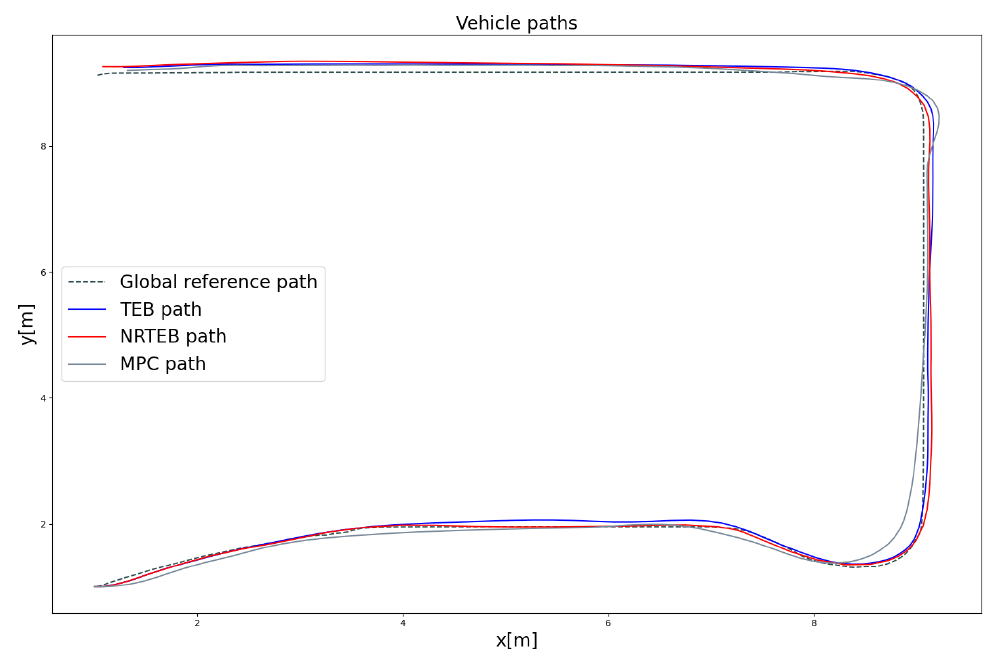
Figure 12. The traces of the robot’s odometry. The gray dashed line is the global reference path that was pre-recorded and published in the experiment. The starting pose is ( 1,1,0 ) T and the ending pose is ( 1,9, π ) T .